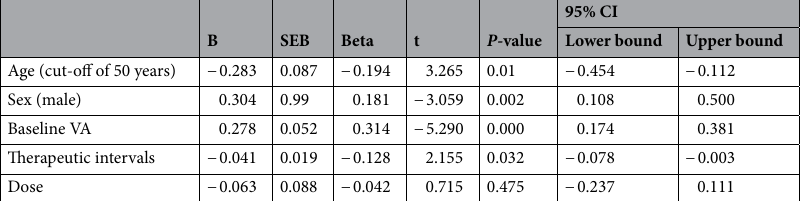
Table 2. Linear regression analysis to therapeutic effect of IVMP therapy. IVMP intravenous methylprednisolone pulse, B unstandardized regression coefficient, SEB standard error of the coefficient, VA visual acuity, CI confidence